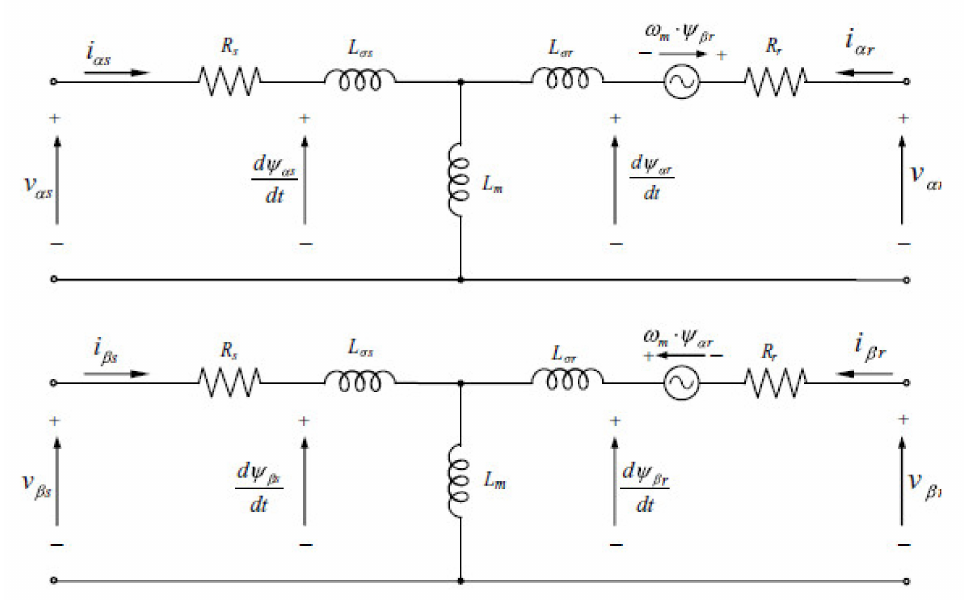
Figure 2. DFIG model (equivalent circuit) in the α - β reference frame [17] (p.